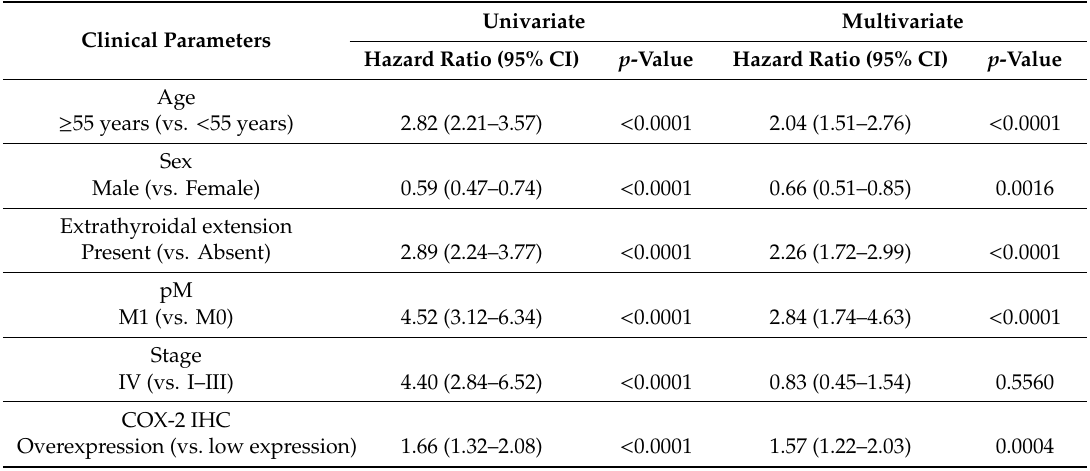
Figure 2. Survival analyses of COX-2 protein expression in the overall cohort and based on BRAF mutation status. ( A ) Kaplan–Meier survival plot showing statistically significant poor disease-free survival in COX-2 high-expression cases compared to COX-2 low-expression cases ( p < 0.0001); ( B ) Kaplan – Meier survival plot showing no statistically significant difference in disease-free survival for COX-2 expression in BRAF wild-type PTC ( p = 0.7675); ( C ) Kaplan–Meier survival plot showing statistically significant poor disease-free survival for cases with COX-2 overexpression in BRAF -mutant PTC ( p < 0.0001). Table 3. Univariate and multivariate analysis of COX-2 expression using the Cox proportional- hazards